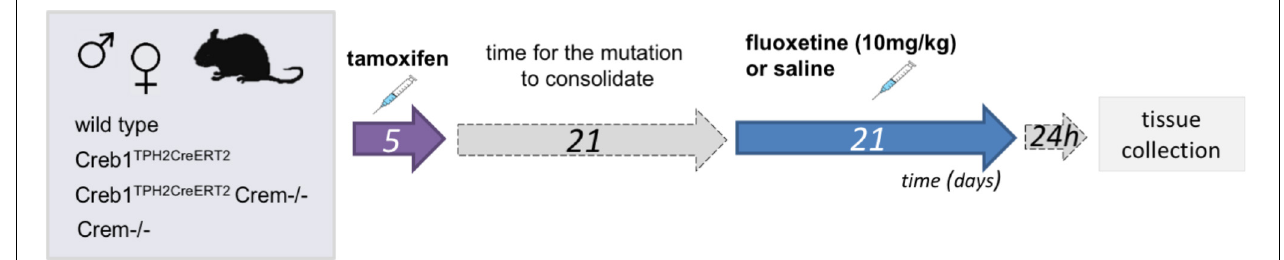
FIGURE 1 | Flowchart summarizing the experimental